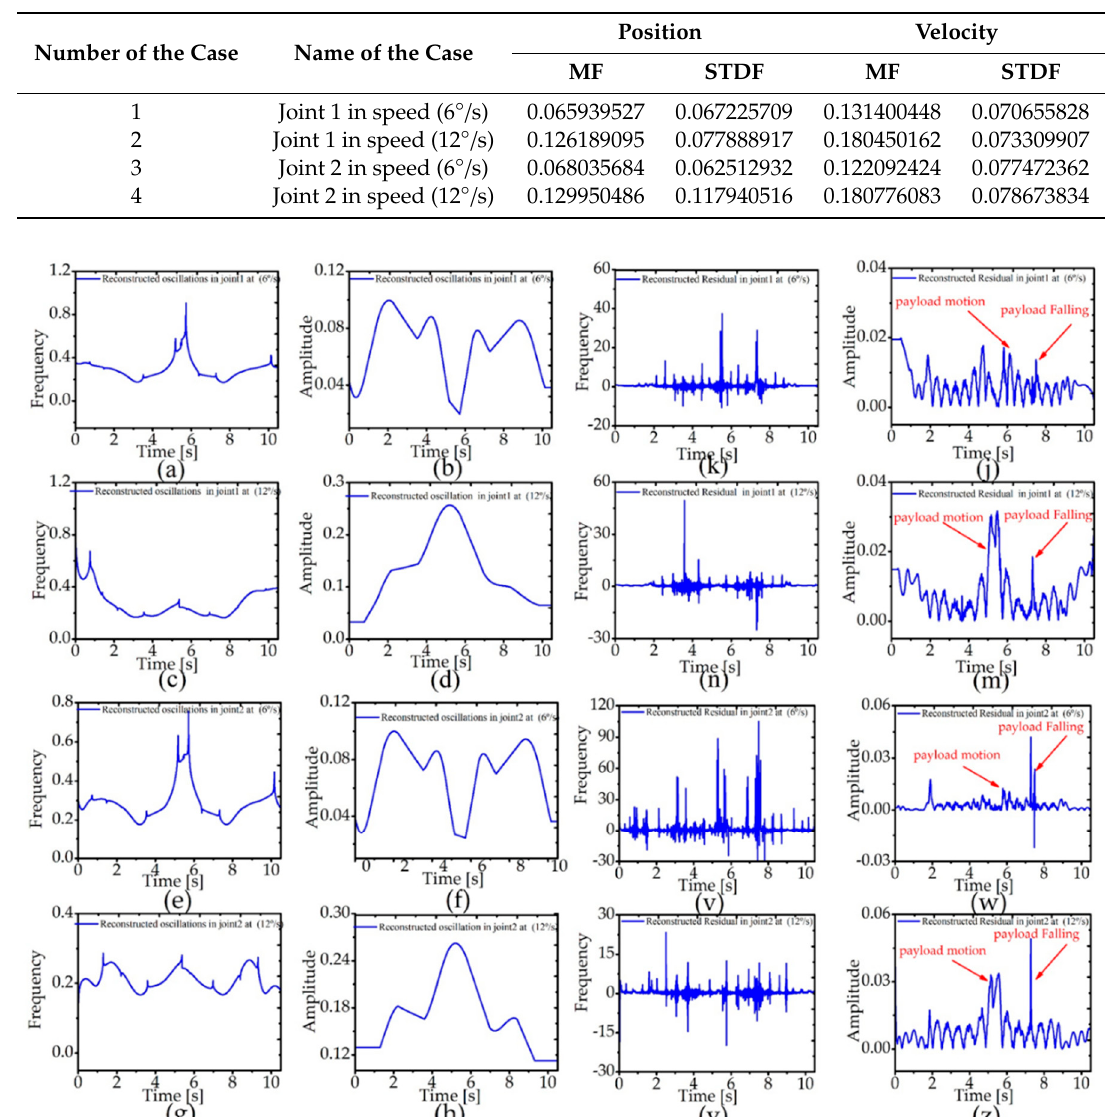
Table 7. Mean Frequency (MF) and Standard Deviation Frequency (STDF) for both position and velocity for the reconstructed oscillations by the SSAHT technique. (Unit: ◦ ).